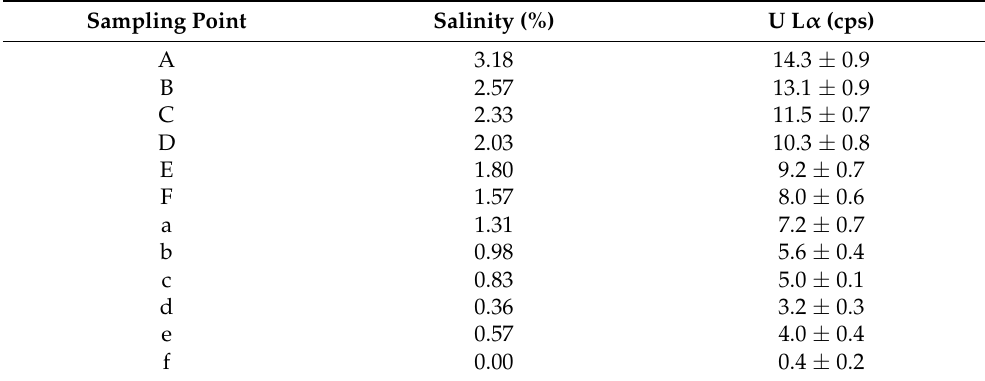
Table 1. Salinity values and U Lα peak signal intensities at the various sampling points. Sampling